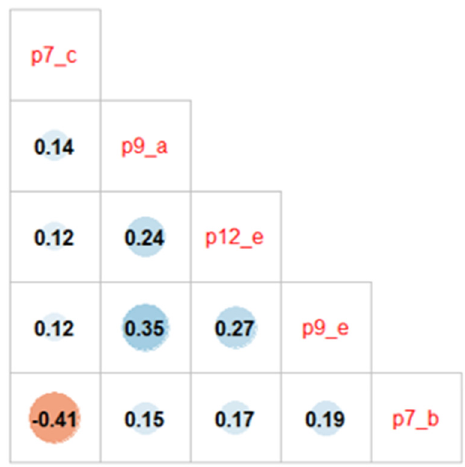
Figure 5. Correlations between the didactics of the social sciences and the design of interdisciplinary and globalizing didactic projects.